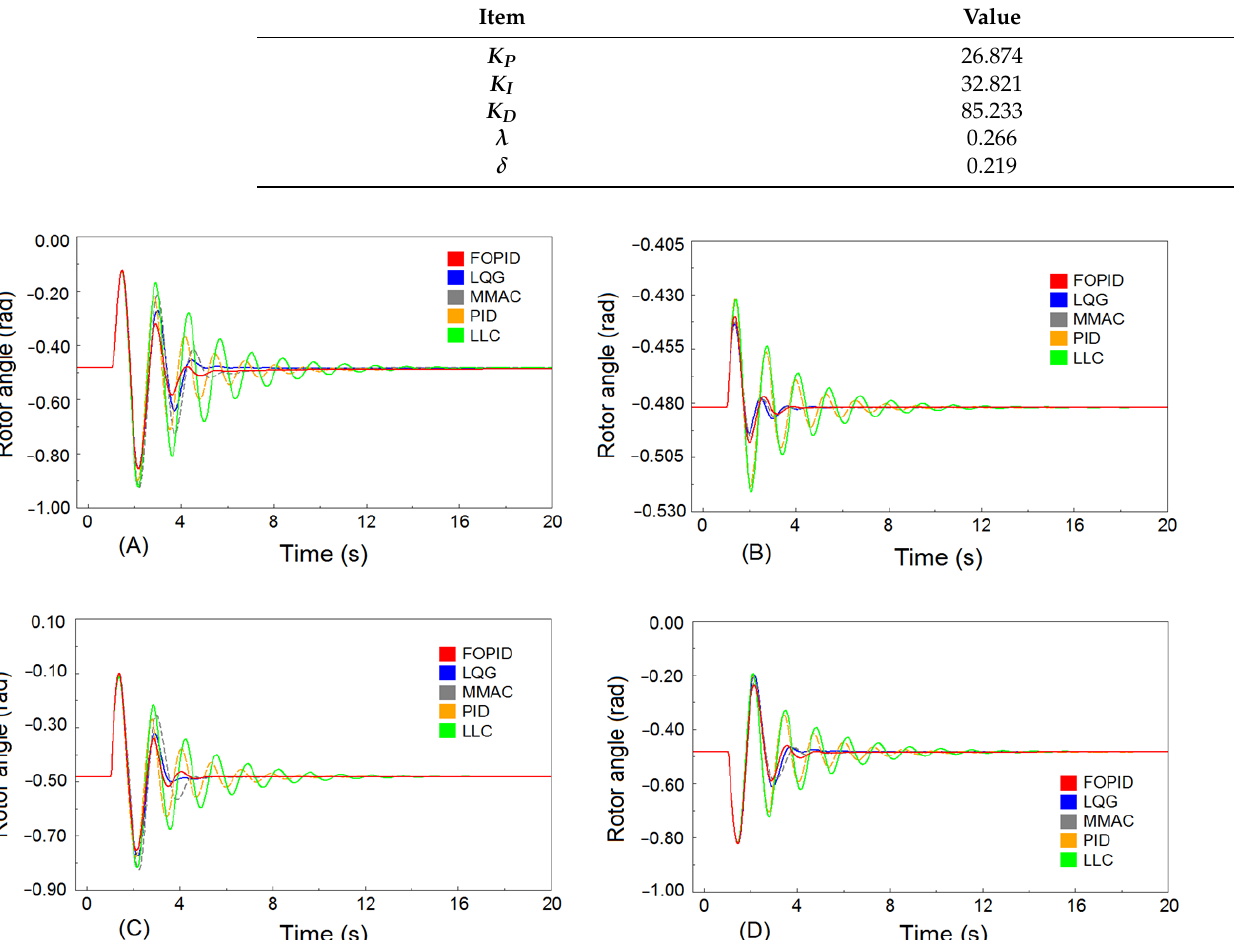
Figure 17. Rotor angle of generator G1 for scenario 3: ( A ) state 1, ( B ) state 2, ( C ) state 3, and ( D ) state 4.